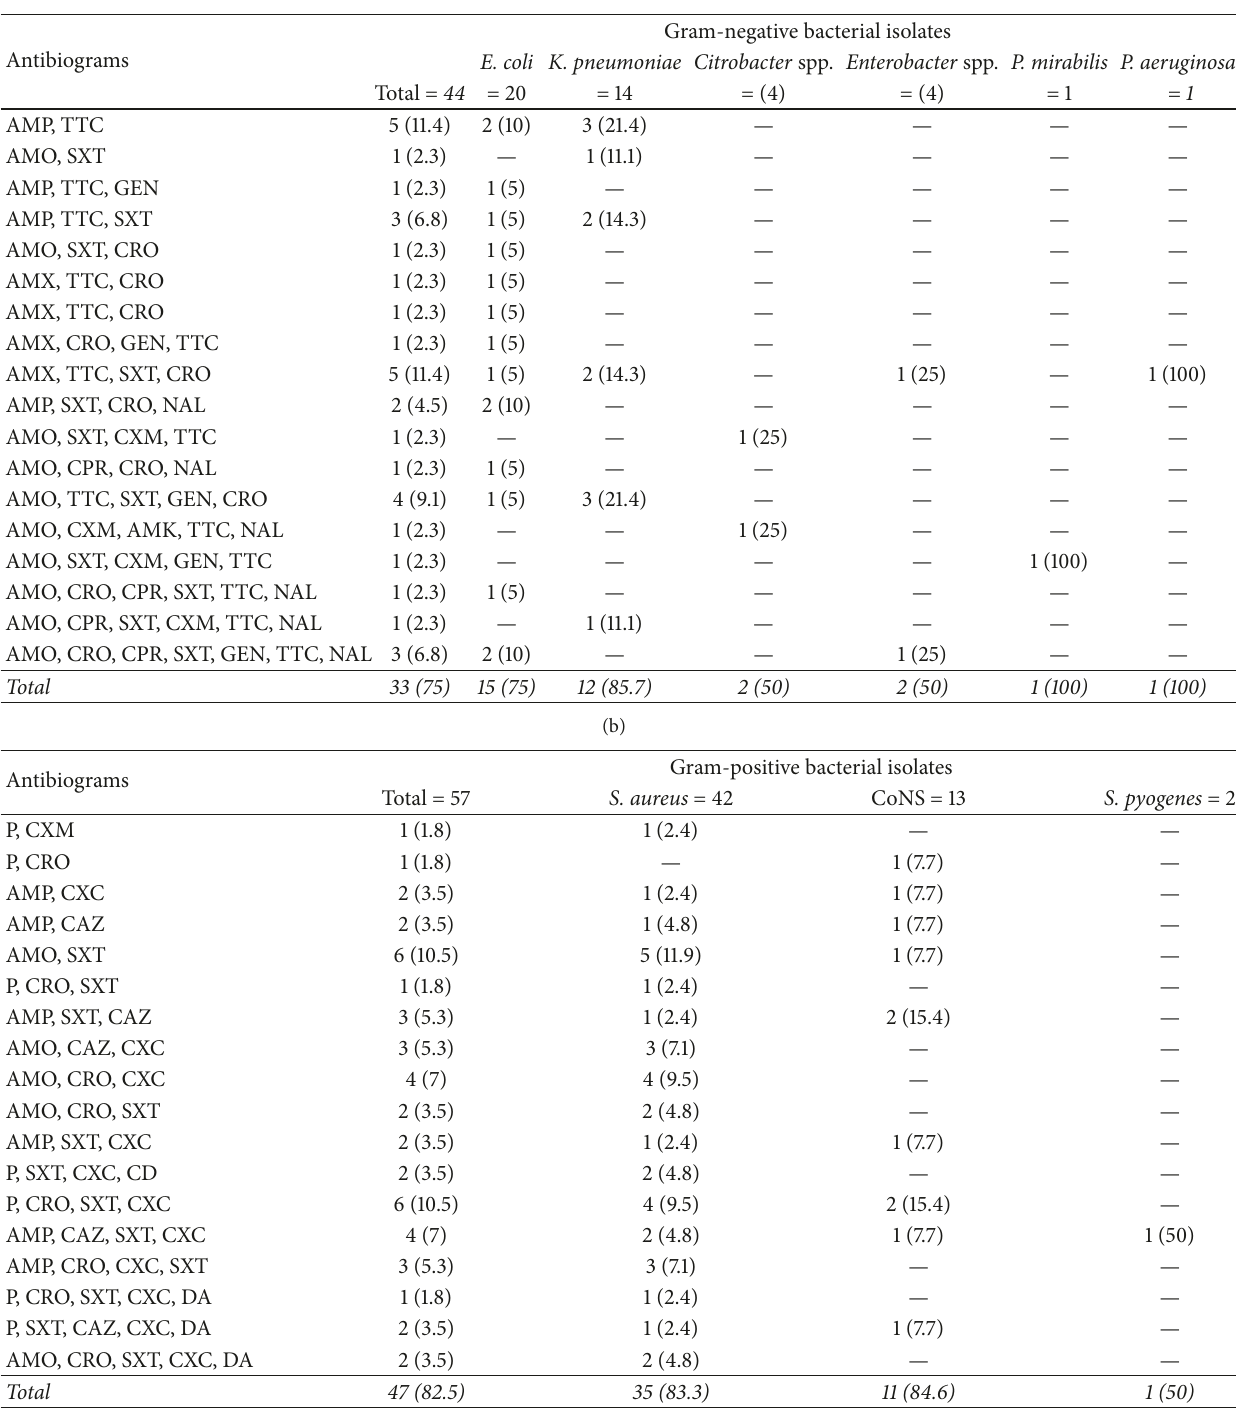
Table 4: Multidrug resistance (MDR) of Gram-negative and Gram-positive bacterial isolates from women attending antenatal and postnatal